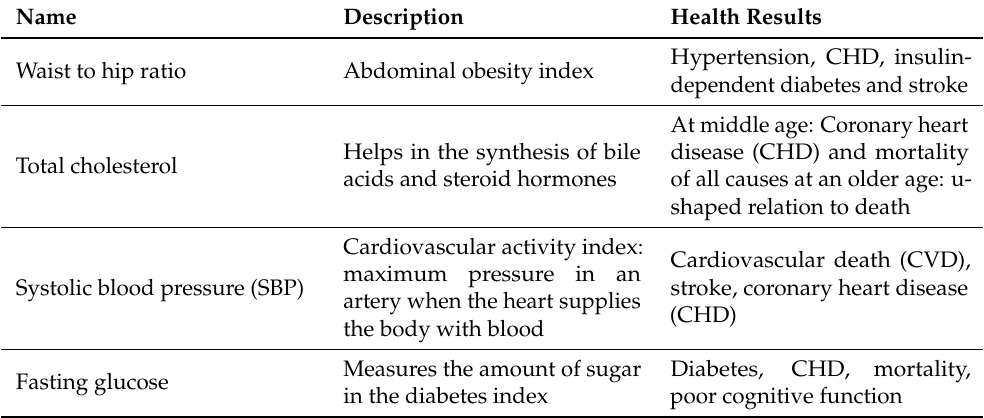
Table 1. Examples of